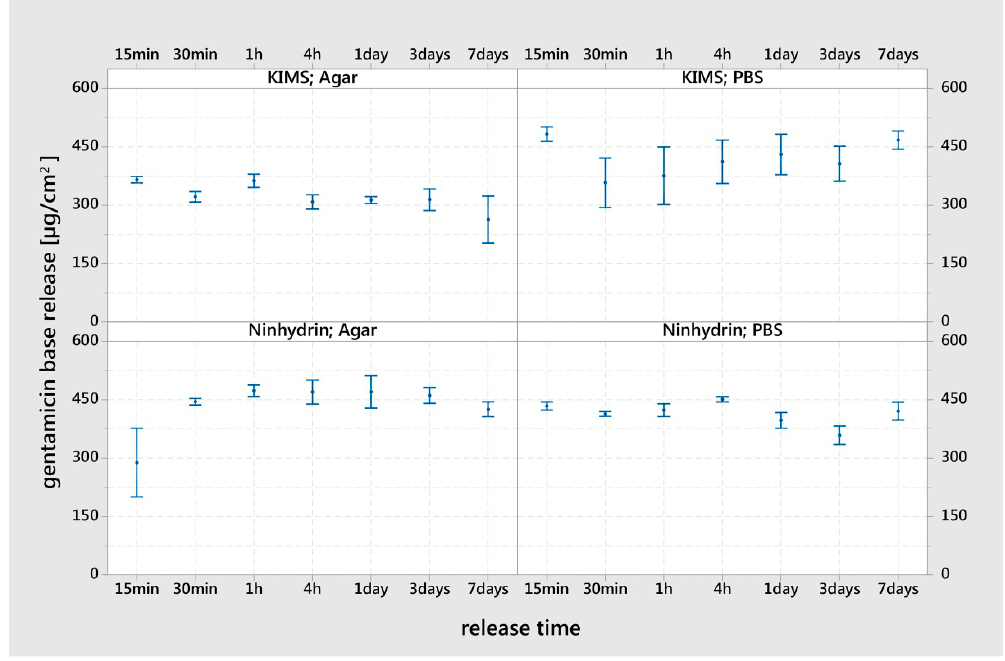
Figure 2. Gentamicin release in vitro over a period of seven days from the G hybrid K-wire pieces (loaded with 290 mg/mL gentamicin sulfate) incubated in phosphate buffered saline (PBS) or agar medium. The measurements were performed in individual replicates (ninhydrin n = 9, kinetic interaction of microparticles in solution (KIMS) n = 3). The results are displayed as mean values and standard errors.